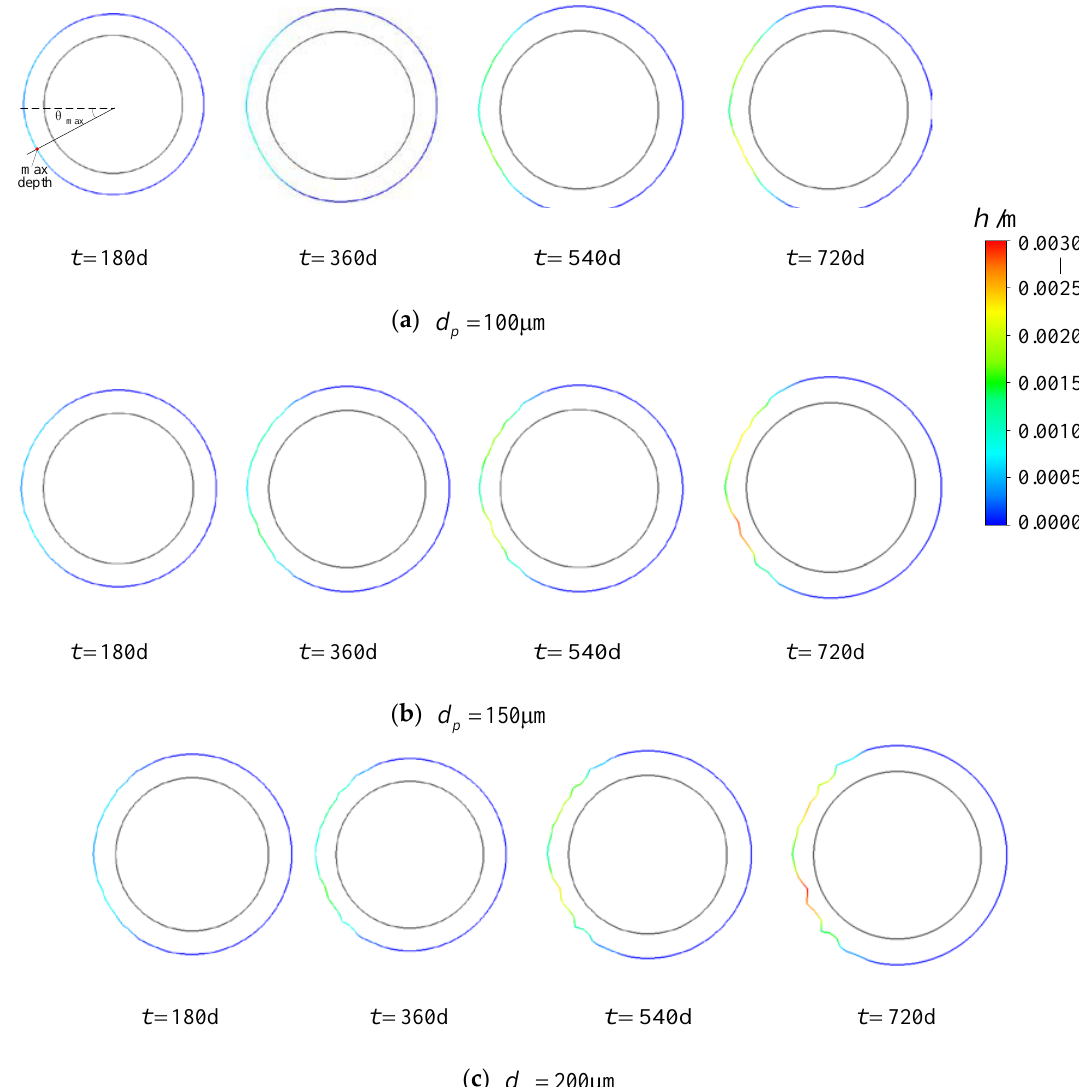
Figure 12. Evolution process of erosion profile in the first row.